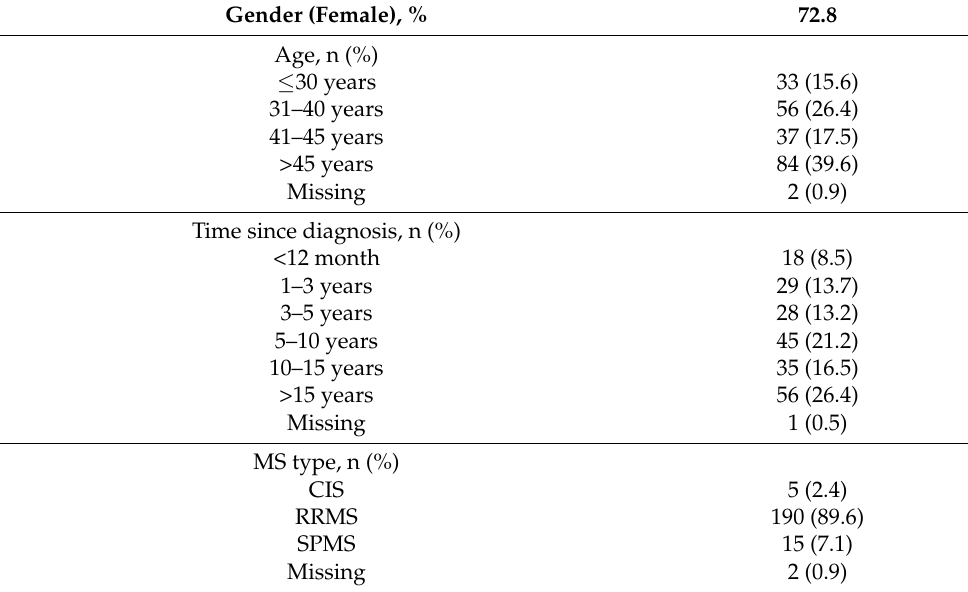
Table 1. Patients characteristics (n =